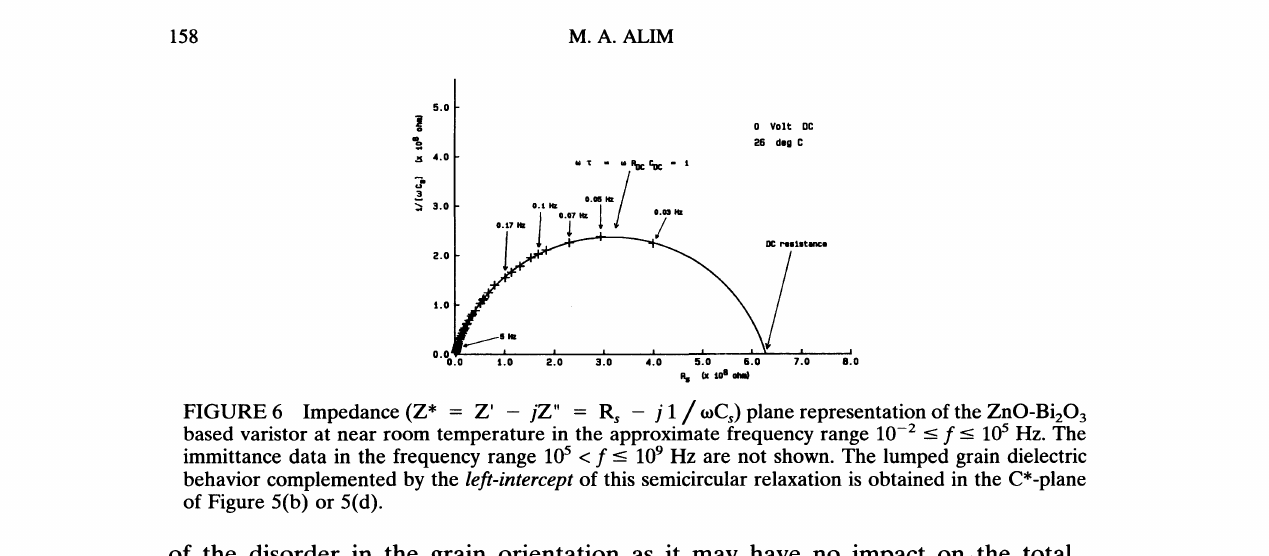
FIGURE 6 Impedance (Z* Z’ ]Z" R / 1 / toCs) plane representation of the ZnO-Bi203 based varistor at near room temperature in the approximate frequency range 10 -2 -< f -< 105 Hz. The immittance data in the frequency range 10 < f -< 10 Hz are not shown. The lumped grain dielectric behavior complemented by the left-intercept of this semicircular relaxation is obtained in the C*-plane of Figure 5(b) or 5(d).